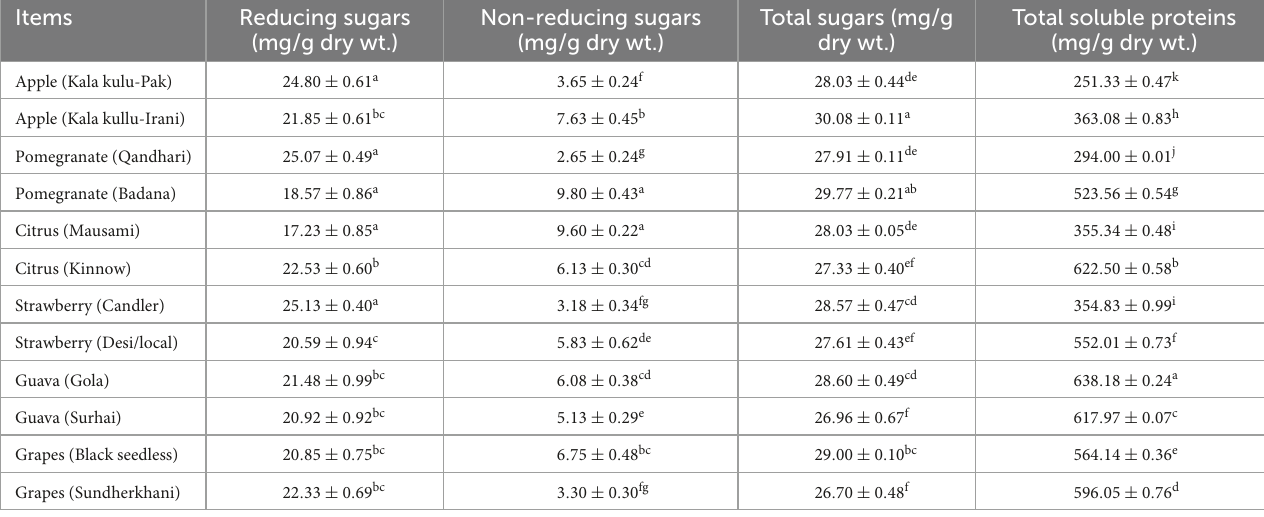
TABLE 2 Biochemical indices of different fruits varieties (peels).